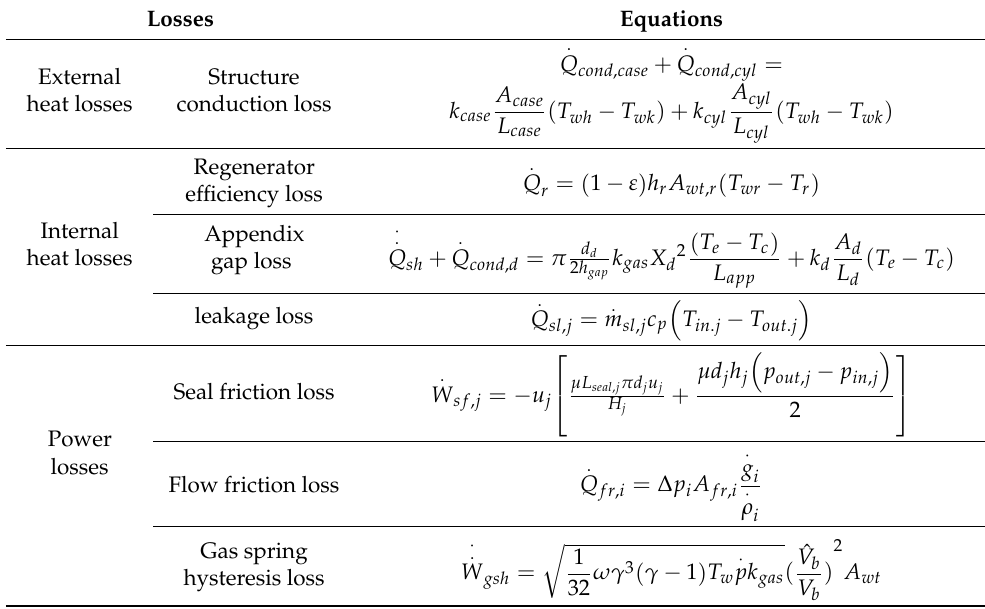
Table 6. Definitions of losses and corresponding equations (here, i = c , k , r , h , e , and j = p , d , rod ).